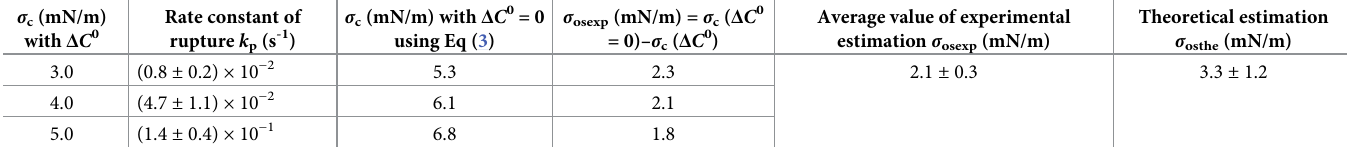
Table 3. An estimation of membrane tension of DOPG/DOPC (40/60)-GUVs for Δ C 0 = 13 mOsm/L and C out = 375 mOsm/L. Rate constant of σ c (mN/m) σ c (mN/m) with Δ C 0 = 0 with Δ C 0 rupture k p (s -1 ) using Eq (3)